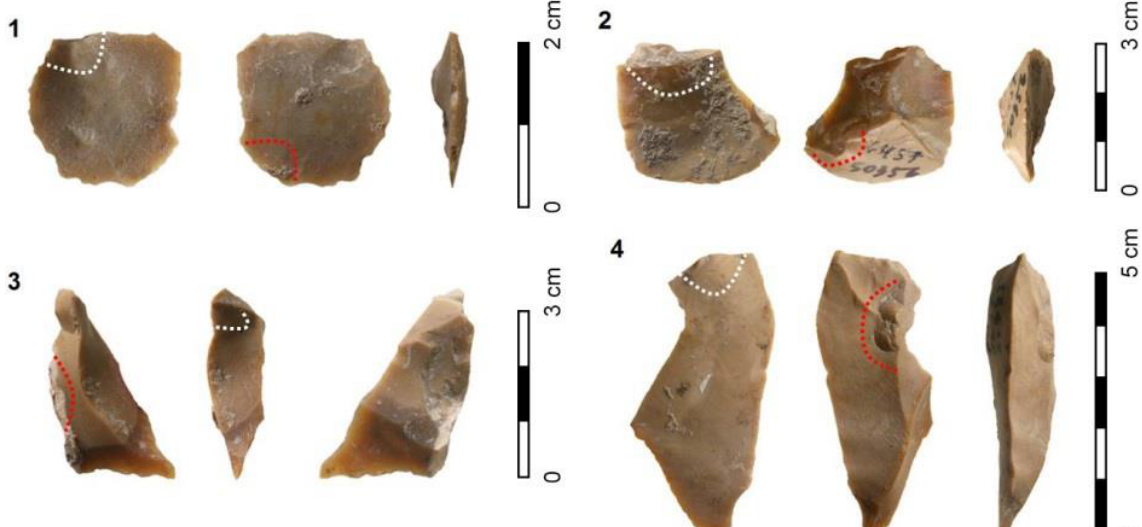
Figure 10. Double bulb (DB) items: 1 & 2 are DB Kombewa items; 3 & 4 are DB Tabun Snap items. Dotted red lines denote the original bulb of percussion on the COF; dotted white lines denote the actual bulb of percussion on the DB